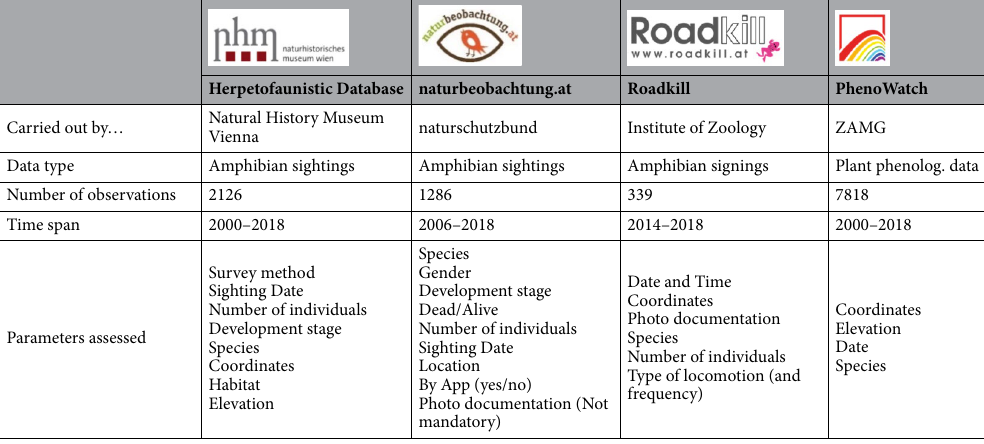
Table 1. Data sources of amphibian observation data and plant phenological